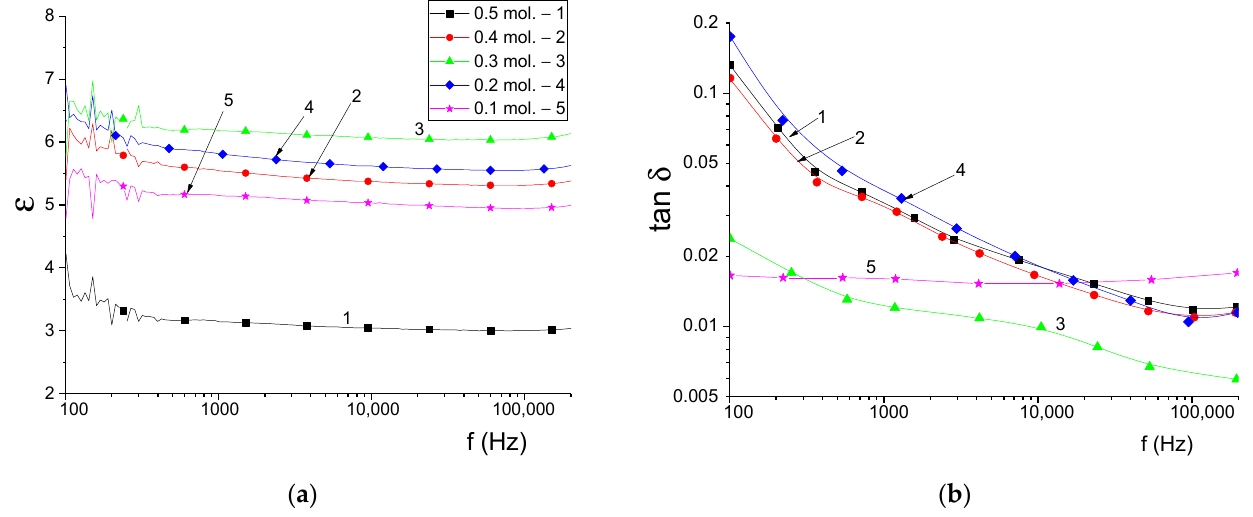
Figure 14. ( a ) Frequency spectra of the permittivity of the obtained samples; ( b ) Frequency spectra of the dielectric loss tangent of the obtained samples.